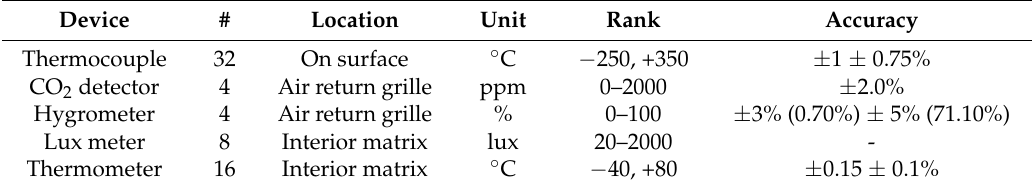
Table 2. Probes in test